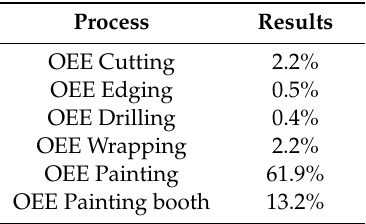
Table 5. OEE Vertical